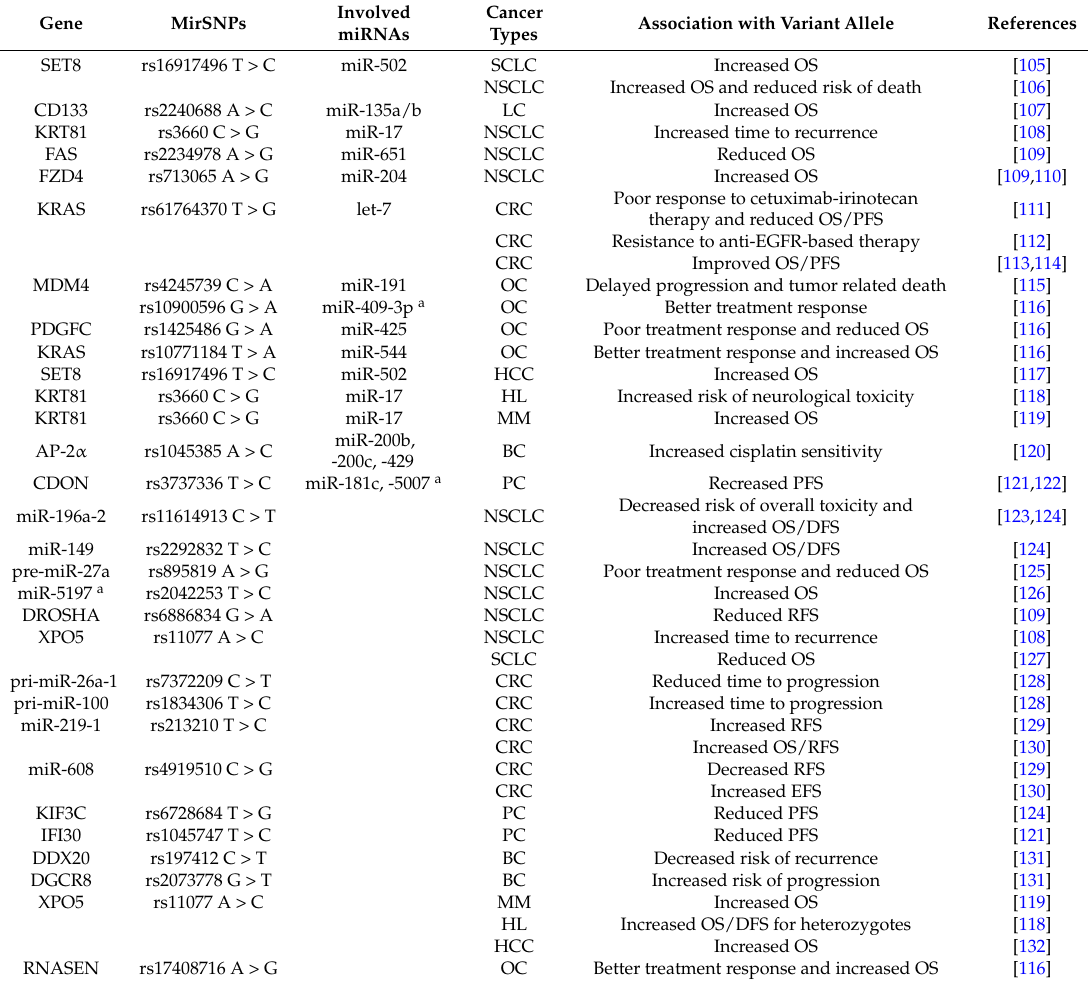
Table 2. MiRSNPs as biomarkers of chemotherapy response and